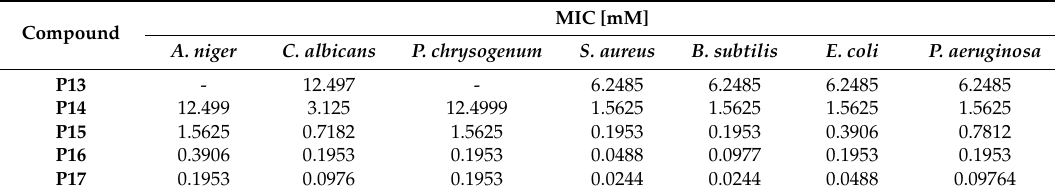
Table 3. Antimicrobial properties of P13 – P17